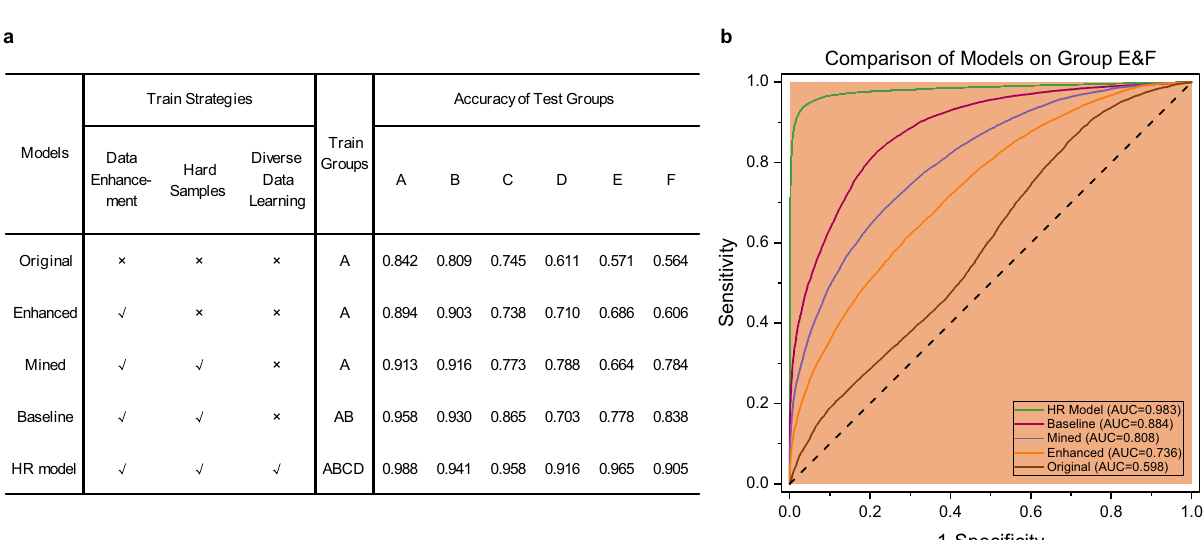
Fig. 6 Importance of designed data enhancement, hard sample mining, and diverse data learning. a The ablation experimental results about the designed three learning strategies of data enhancement, hard sample mining, and diverse data learning on the HR model. We used these learning strategies to train a series of control models step by step, and gave the classi fi cation accuracies on the test sets of groups A – F. b AUC-ROC comparison of the original, enhanced, mined, baseline, and HR models on groups E and F.